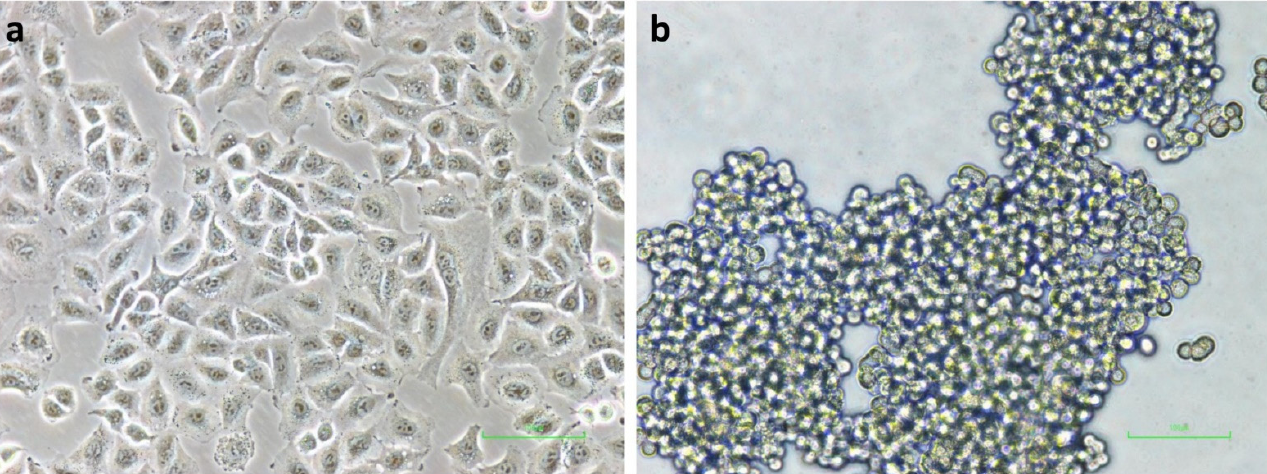
Figure 3. Morphology of ( a ) A549 attached cells cultured under adherent condition and ( b ) A549 floating cells cultured under non-adherent condition. Original magnification of ×200. Scale bar is 100 μ m.